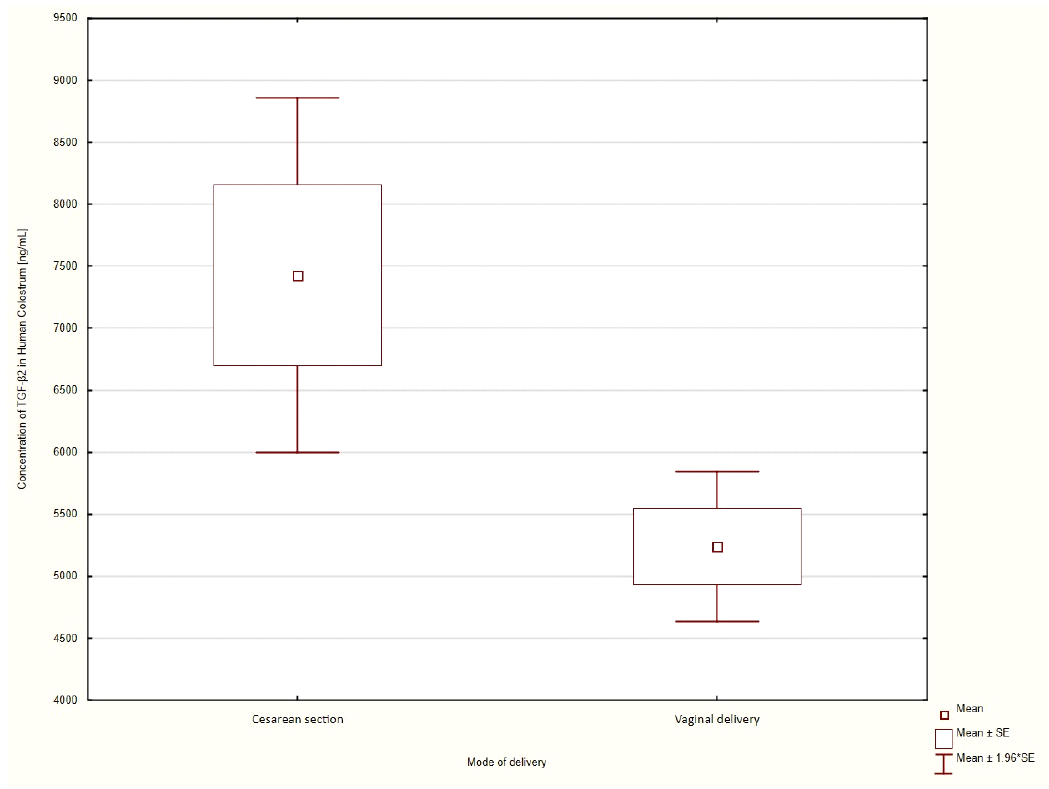
Figure 2. Comparison of mean TGF- β 2 values in patients who had delivered via caesarean section or who delivered vaginally.